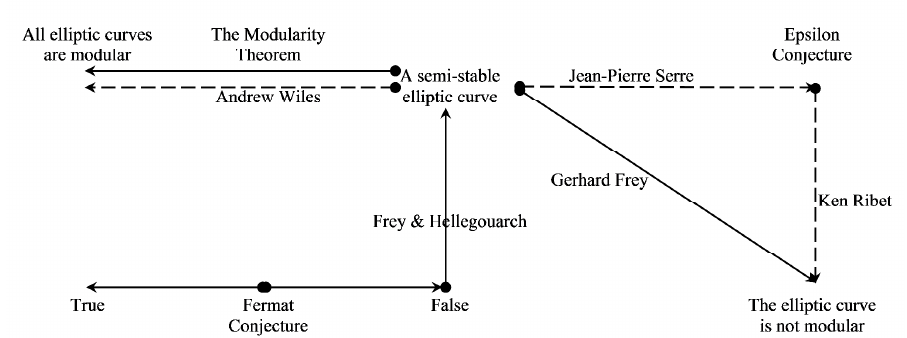
Figure 2. The paths associated with the efforts to prove the Fermat’s Conjecture using geometric elliptic